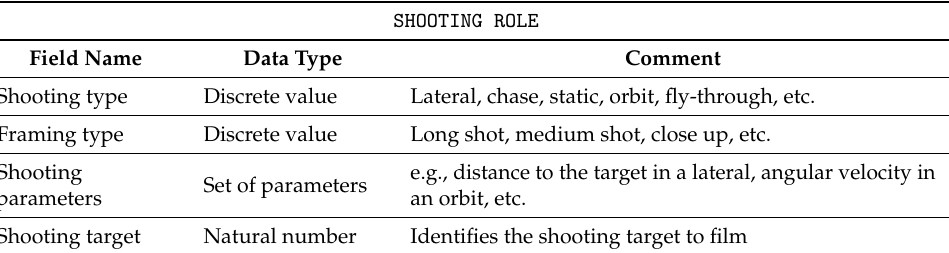
Table 2. Structure for the data type SHOOTING ROLE .